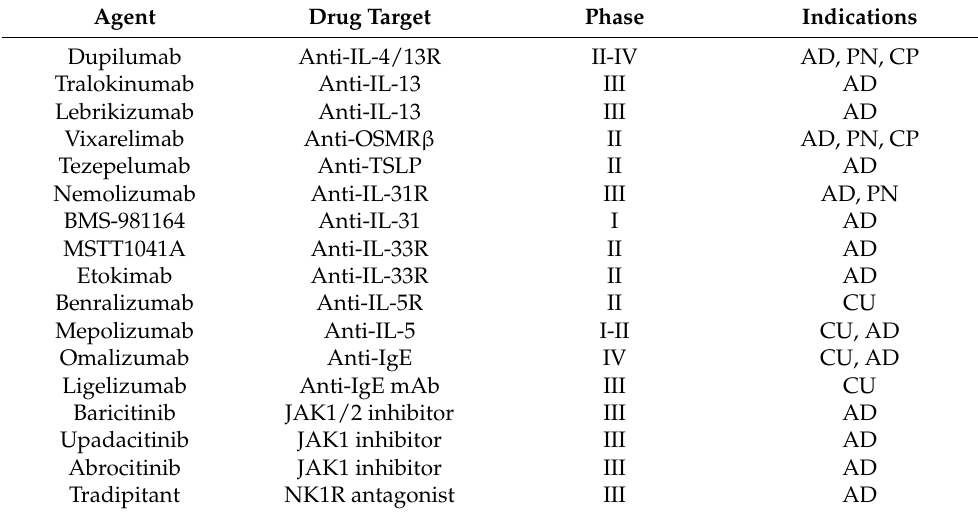
Table 3. Selected systemic agents currently in use and under development for the treatment chronic pruritic skin conditions